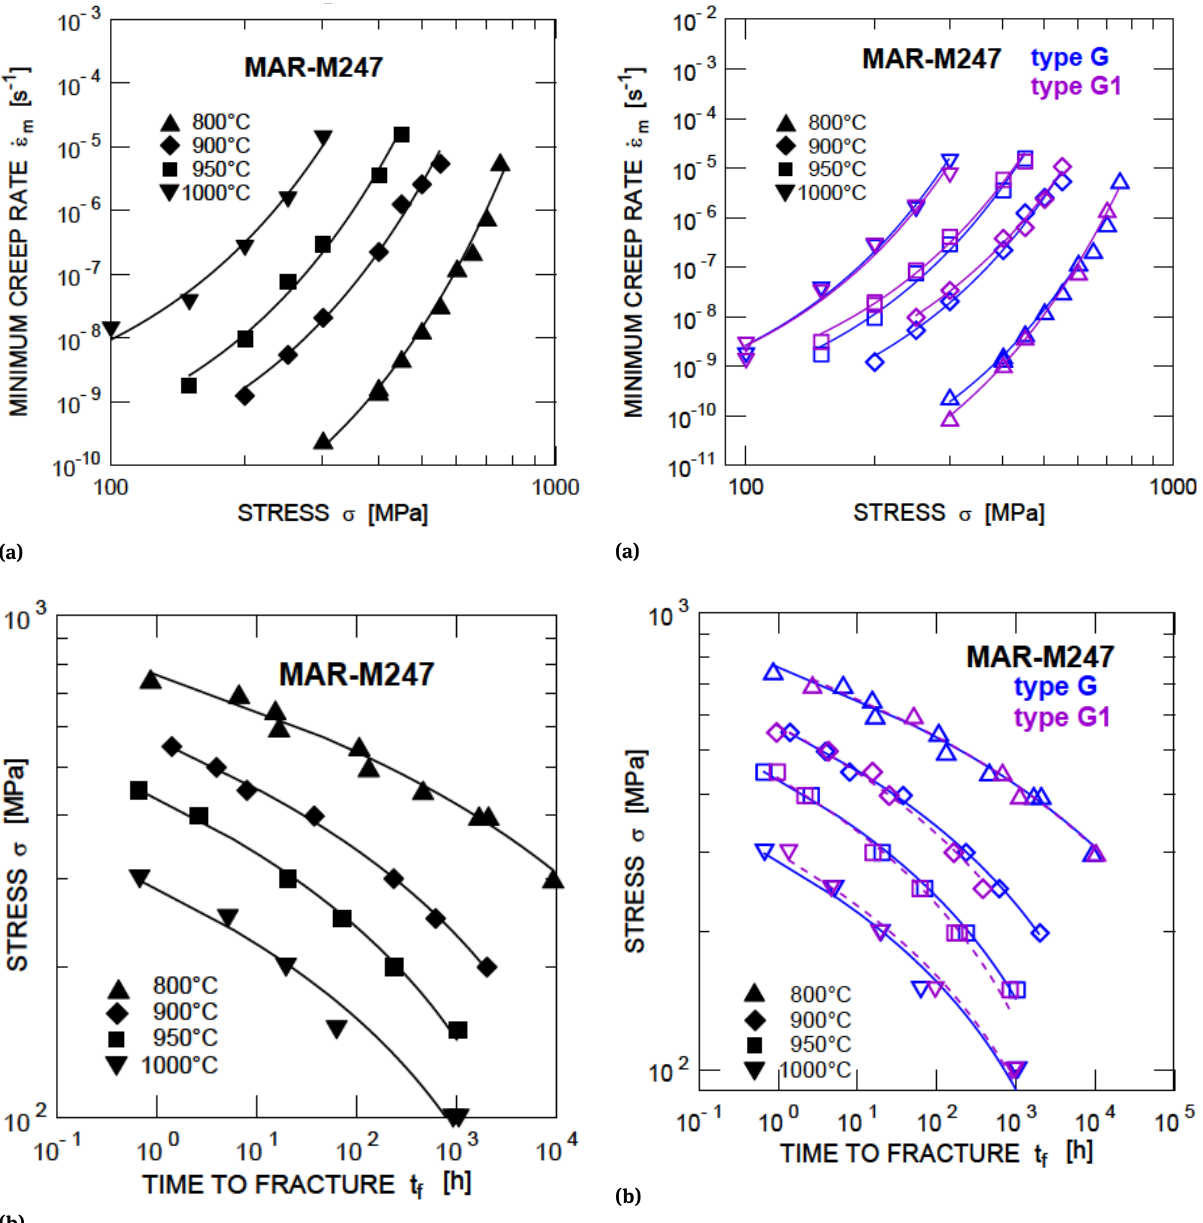
Figure 10: Comparison of the stress dependence of a) minimum creep rate, and b) time to fracture for superalloys MAR-M247 of G variant (solid line) and of G1 variant (dashed